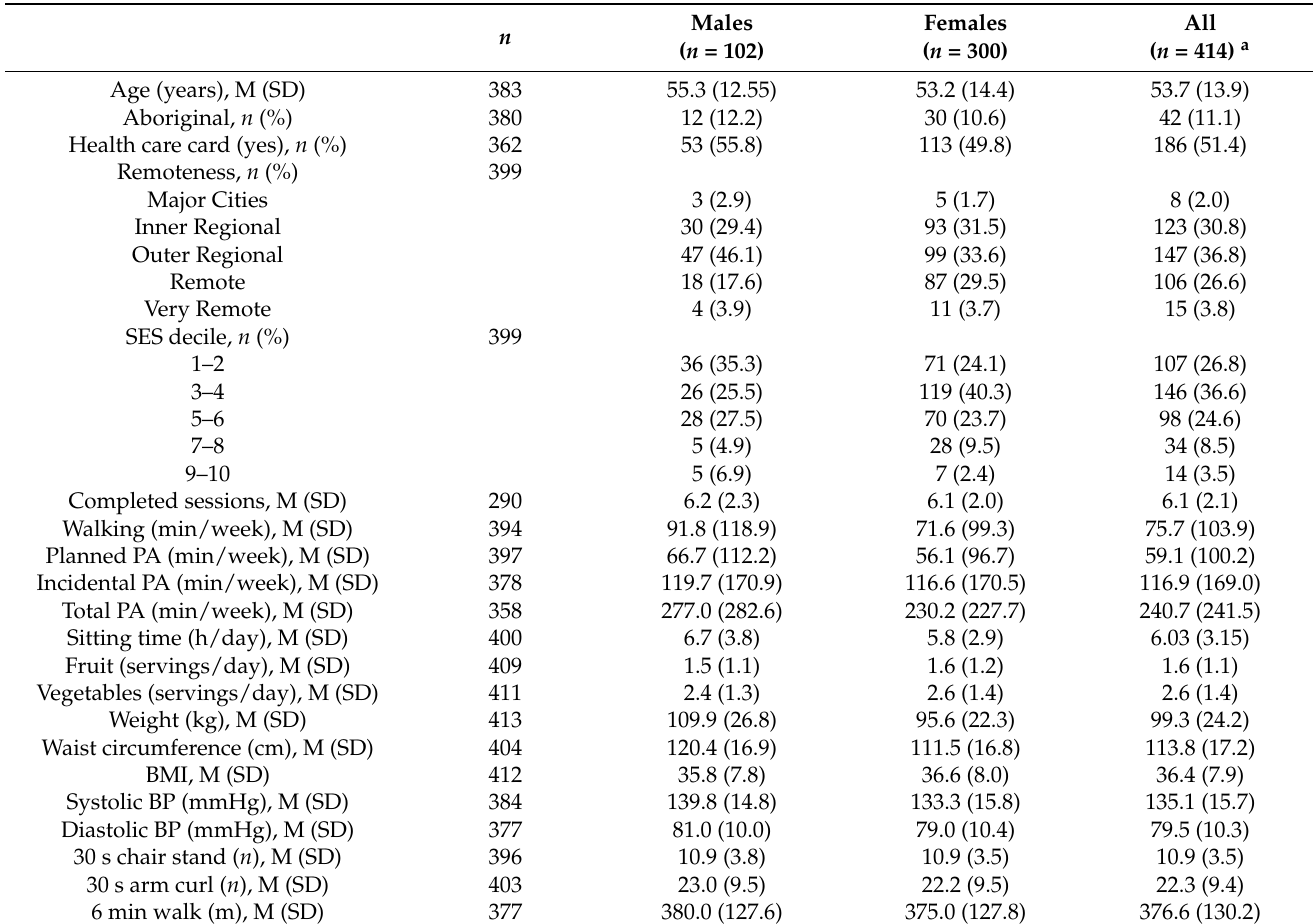
Table 1. Participant characteristics at baseline ( n =